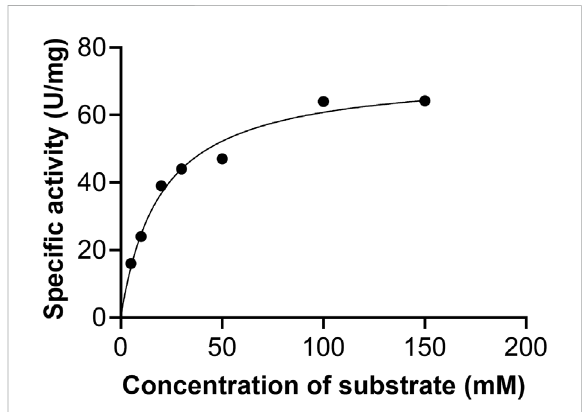
FIGURE 4 Effect of xylitol concentration on the activity of AfXDH. XDH activity of the enzyme was measured in the presence of indicated concentrations of the substrate at pH 9.5. The data represents an average of all statistically relevant results with a standard deviation of less than 15%.